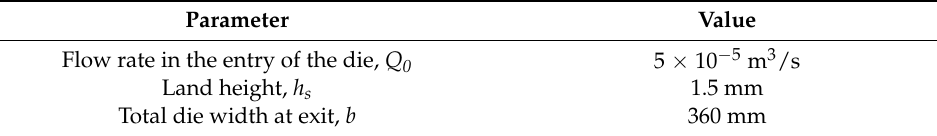
Table 2. Input design parameters of the